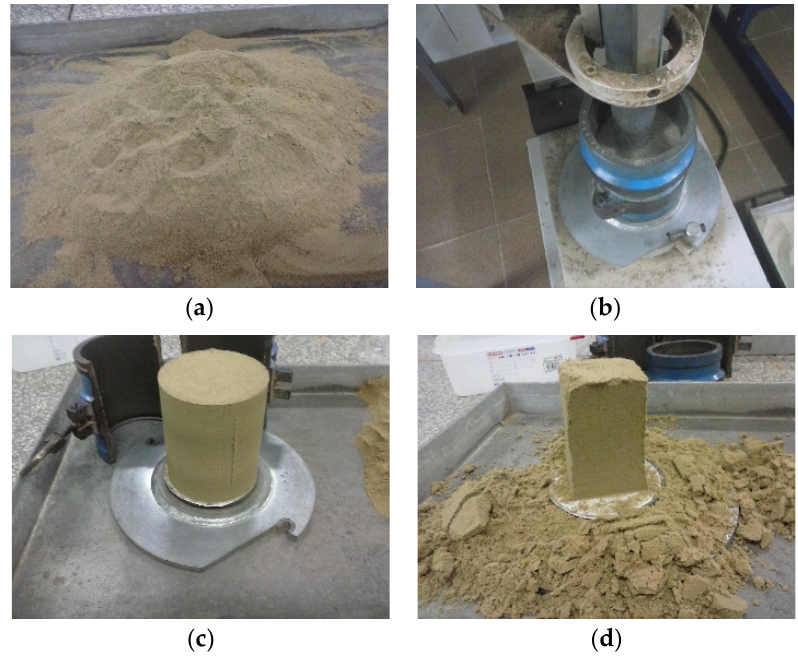
Figure 2. Proctor compaction procedure: ( a ) uniform mixing of the sample for the corresponding water content; ( b ) compacted specimen in an automatic compactor; ( c ) demolding of the compacted specimen; ( d ) cutting the specimen to obtain a representative sample to obtain the moisture content.